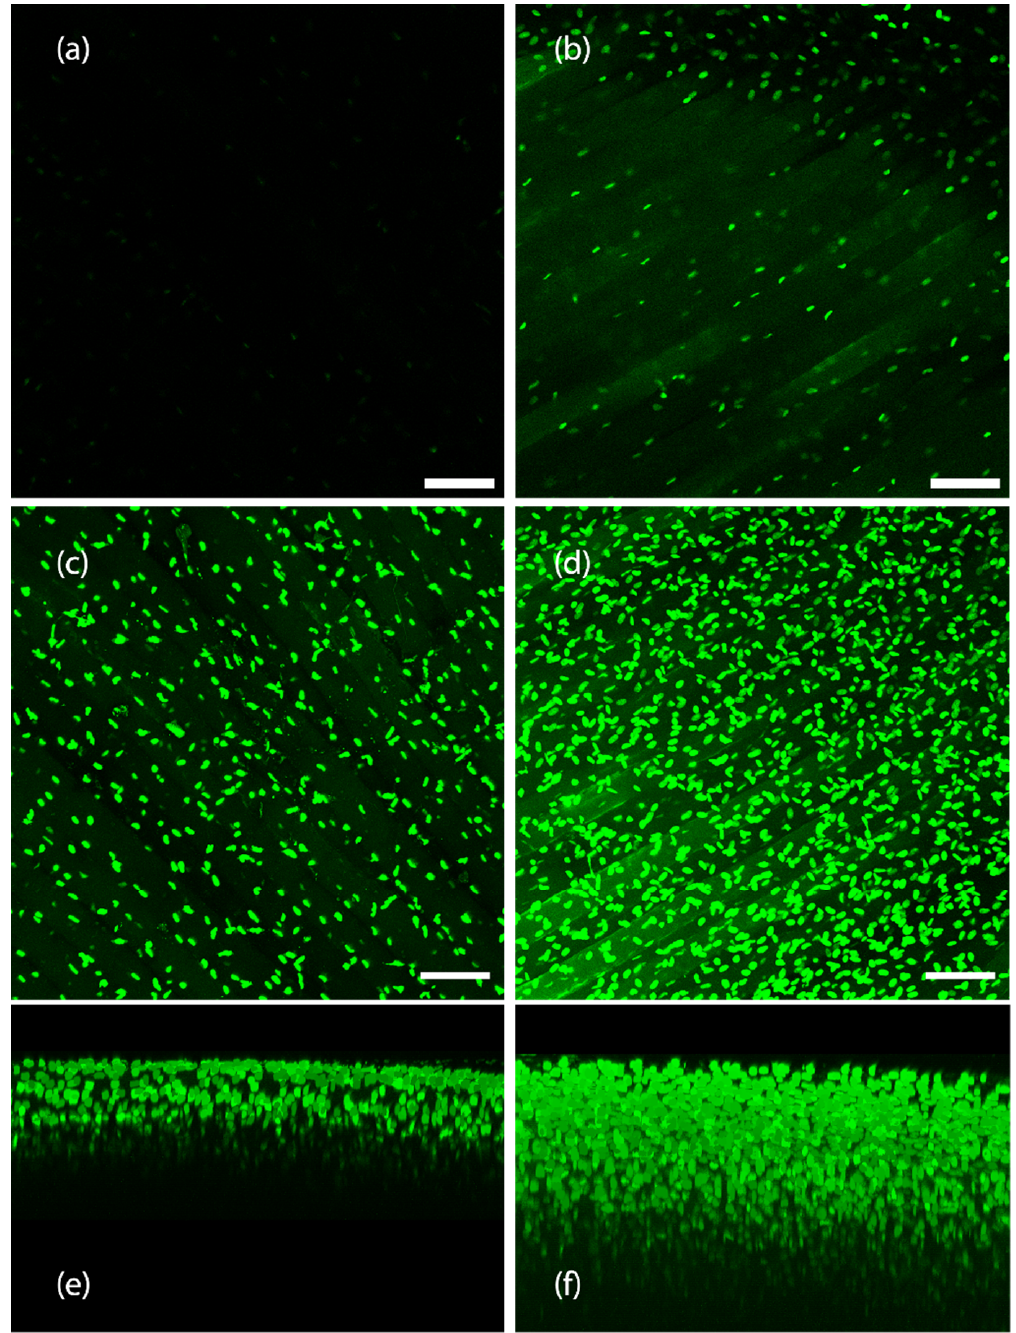
Figure 12. Clearing of a mouse TA muscle tissue using HyClear. ( a , b ) Image slices of a mouse TA muscle using a 20 × lens with GFP-positive fibroblasts, using a 20 × lens, at 150 µ m, ( a ) before and ( b ) after tissue clearing. ( c , d ) MIP image of a mouse TA muscle using a 20 × lens, with GFP-positive fibroblasts, ( c ) before and ( d ) after tissue clearing. ( e , f ) 3-D reconstructed z-stack image of mouse TA muscle € before, and ( f ) tissue clearing. The imageable depth of the tissue increases from about 160 µ m in image ( b ) (before) to about 350 µ m in image ( d ) (after). The scale 16 bars represent 100 µ